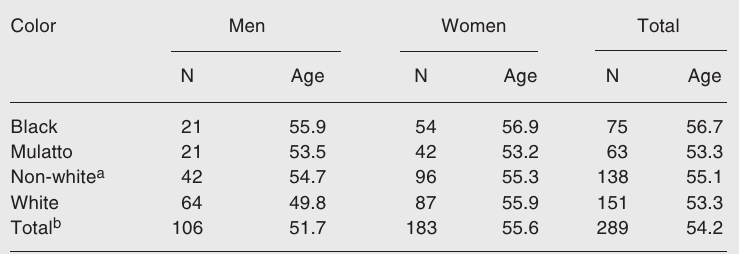
Table 1. Characteristics of the study